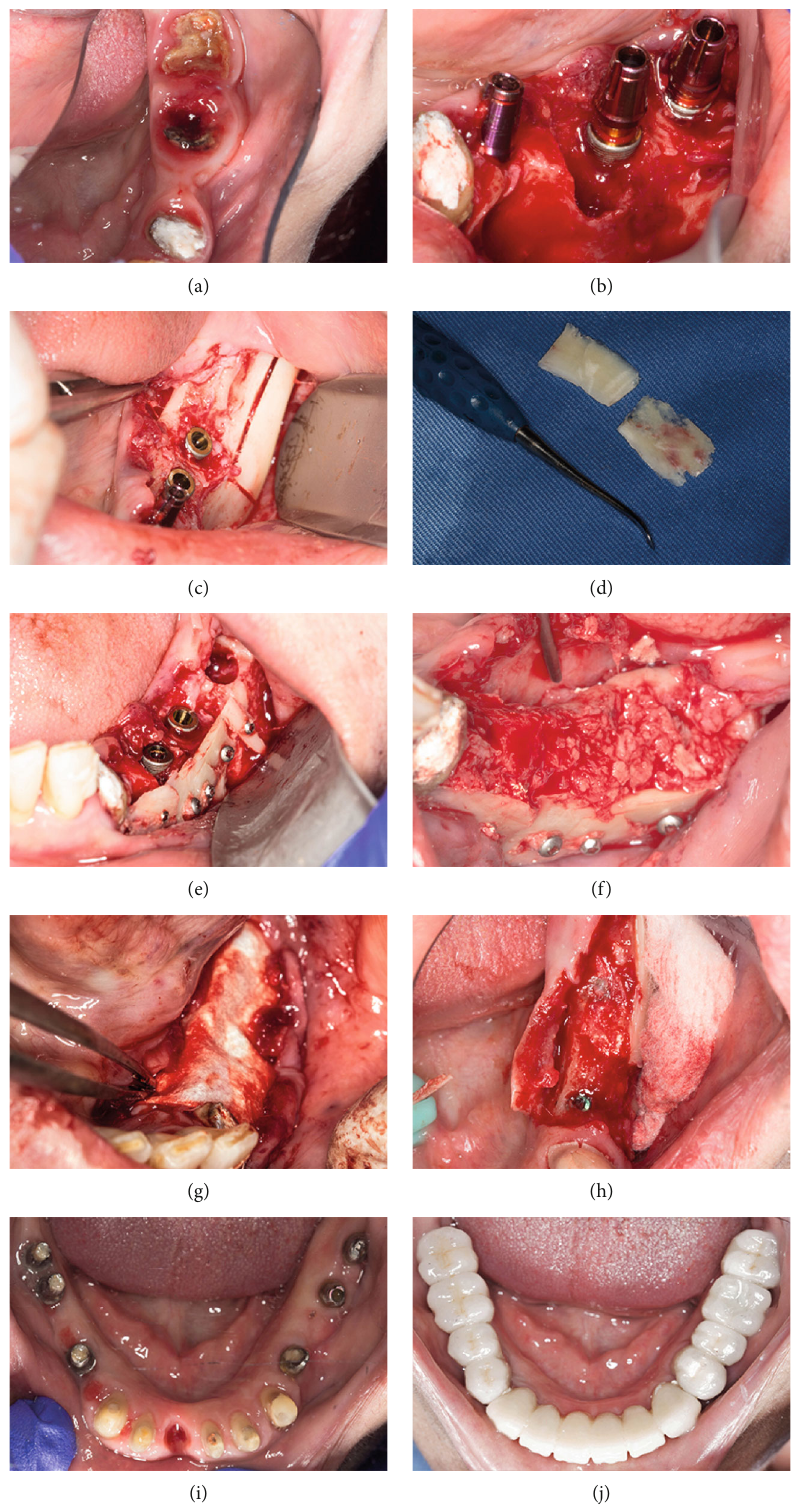
Figure 7: Mandible: (a) Baseline situation of the left hemimandible. (b) Three implants insertion in position #34, #36, and #37. (c) Autogenous bone block harvesting from the external oblique line. (d) Harvested block split in two. (e) Bone block fi xation in the recipient site. (f) Autogenous bony particulates fi lled in the medullary zone. (g) Coverage of the augmentation area by a membrane. (h) Situation at uncovery, 2 months after the augmentation procedure. (i) Abutments and prepared teeth ready to receive their crowns. (j) Mandibular work completed showing the bridges in